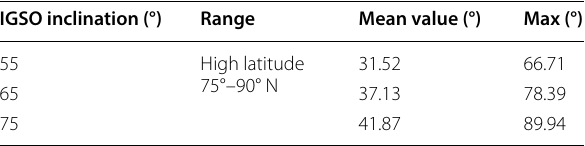
Table 3 Statistics of mean elevation angle with changes of the IGSO inclinations IGSO inclination